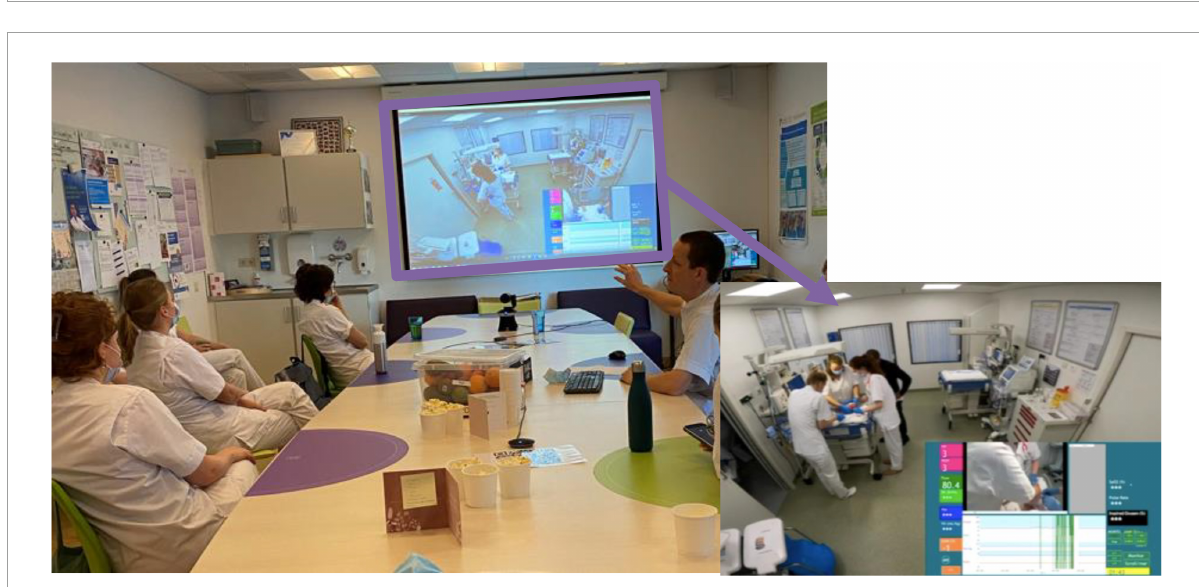
FIGURE2 Video-reflection of a neonatal resuscitation from 2021 onward. Recordings of the hands of the caregivers, the respiratory function monitor and the resuscitation room are visible, with addition of audio. During the video-reflexive sessions, the focus is on the context.